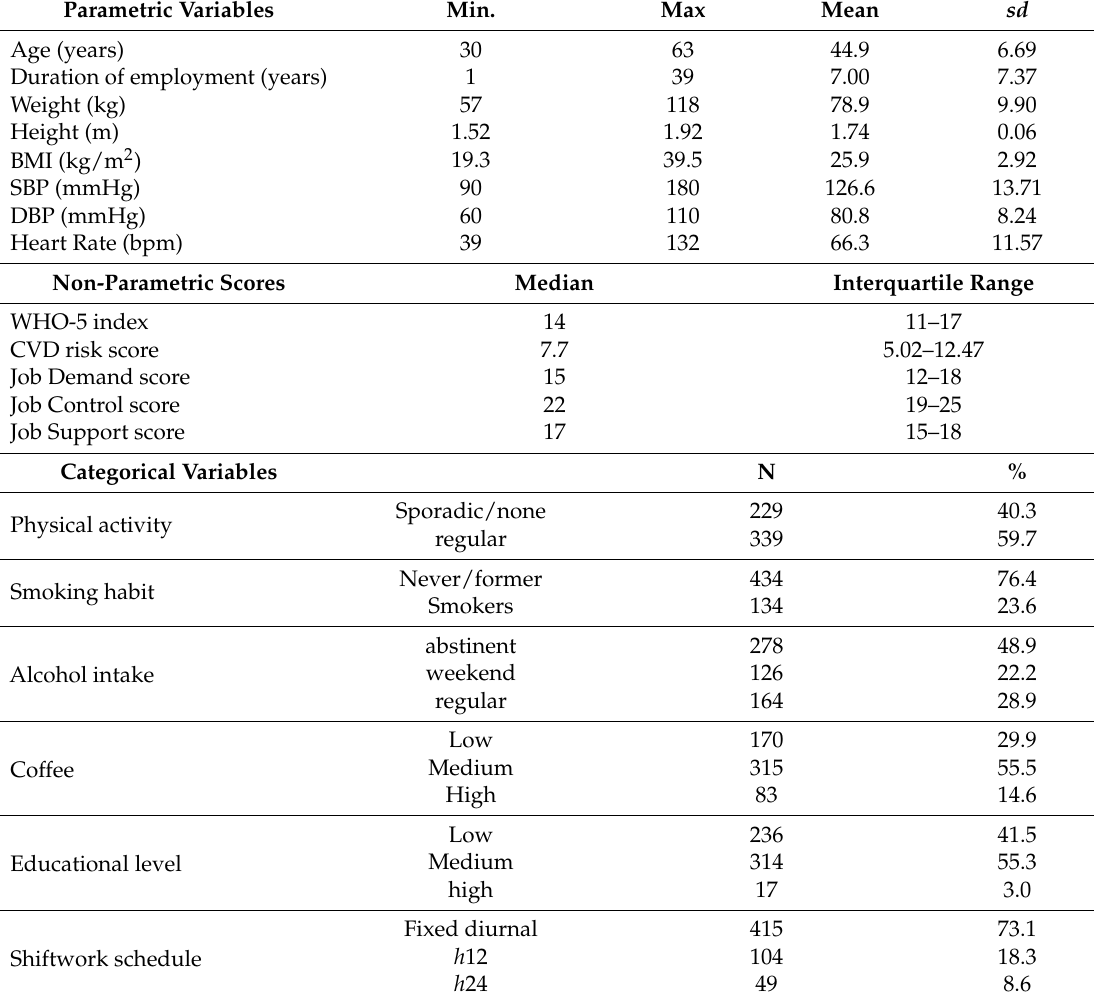
Table 2. Selected variables on the overall study population. Data were available for all the 568